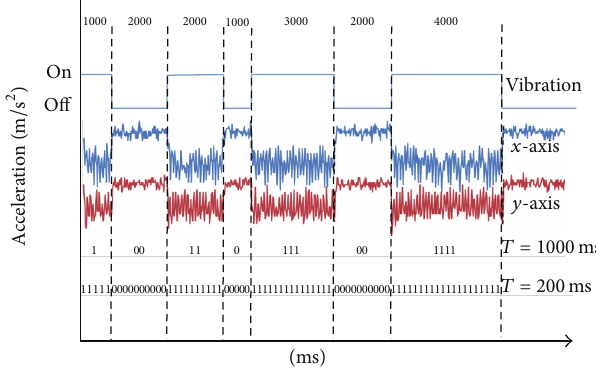
Figure 6: Encoding bits into vibration patterns. The accelerometer raw signals along the 𝑥 and 𝑦 axes are also shown affected by the modulating vibrations. 𝑇 = bit